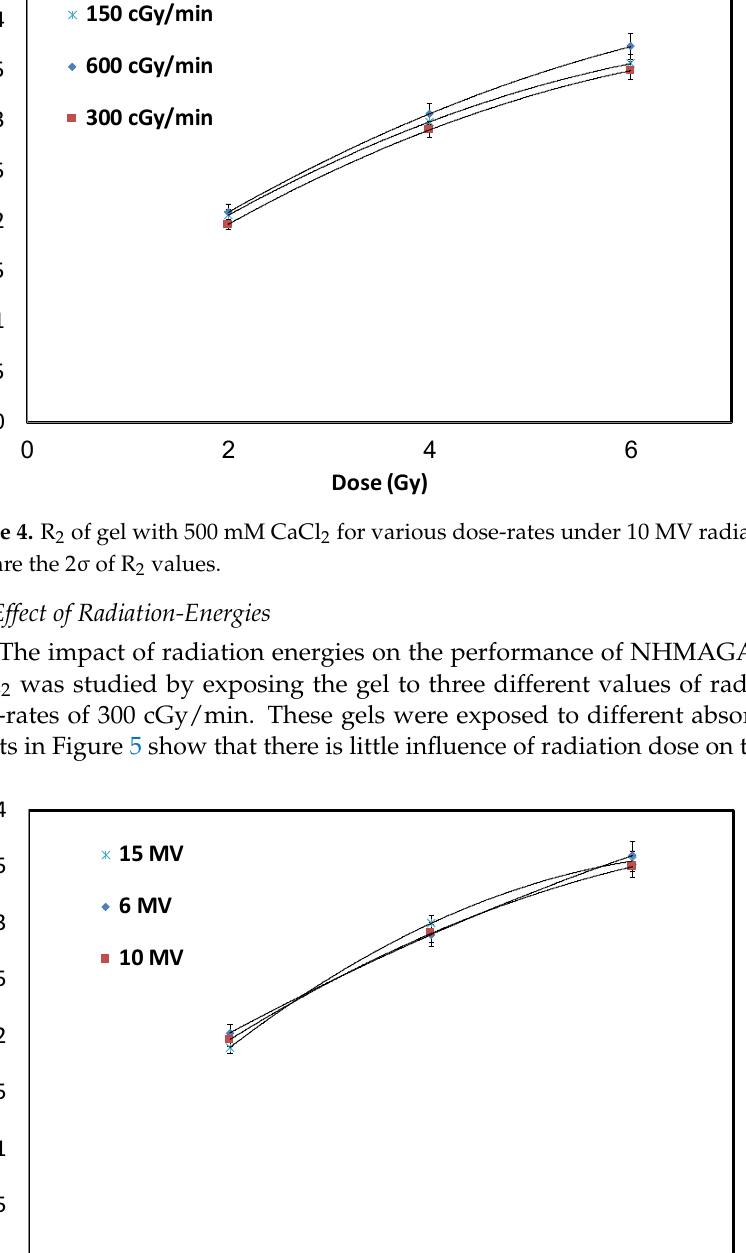
Figure 3. R 2 of gel with 500 mM CaCl 2 irradiated at different doses as a function of storage time. Error bars are the 2 σ of R 2 values.